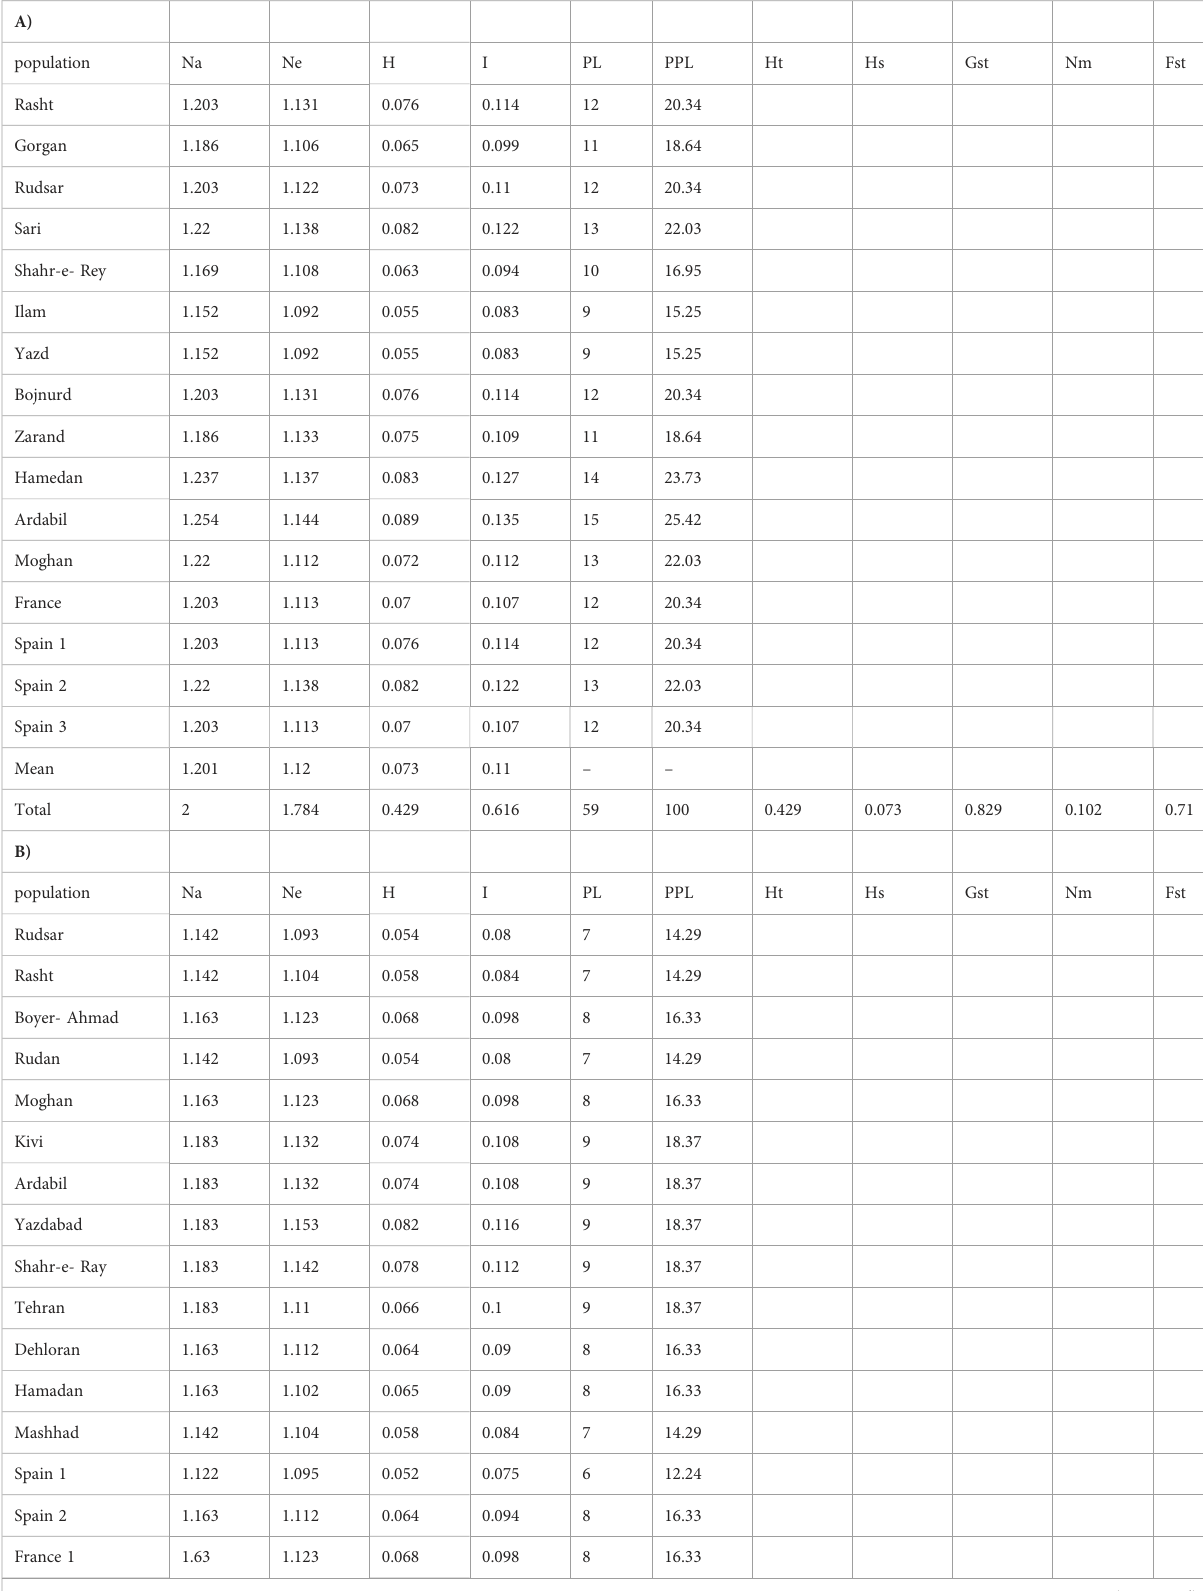
TABLE 4 Genetic diversity data of 16 A. retro fl exus (A) and 17 C. album (B) populations. A)